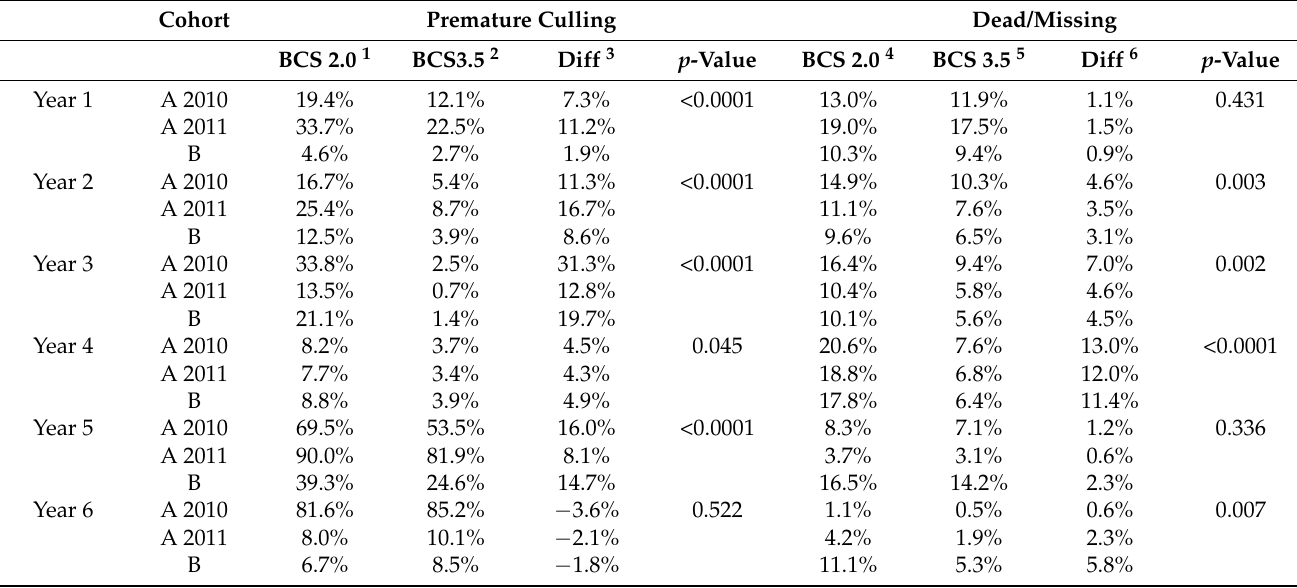
Table 7. For each study year (Years 1–6), the predicted mean cumulative incidence from final multivariable models of wastage due to premature culling and wastage as a result of dead/missing for ewes from three cohorts (Farm A 2010, Farm A 2011, Farm B) on the basis of body condition score (BCS) (BCS 2.0 vs. BCS